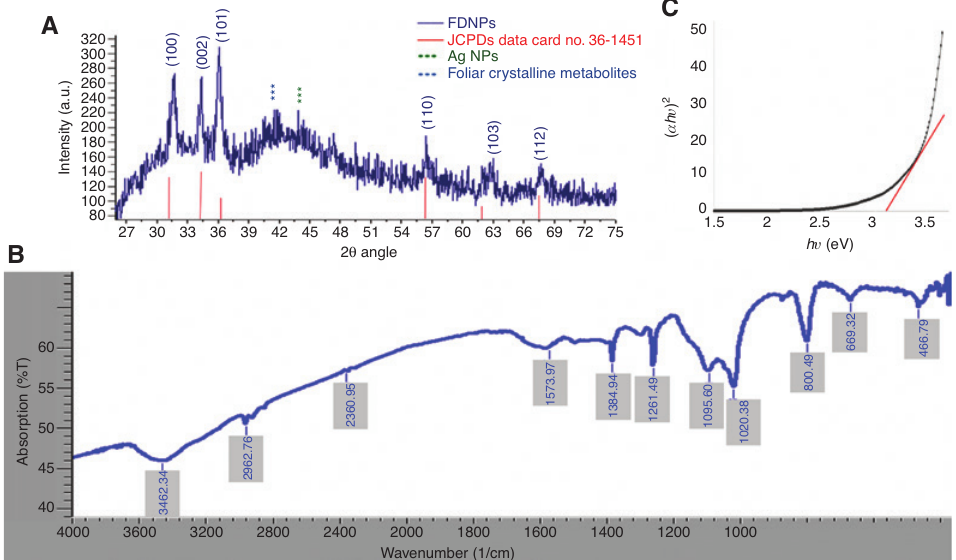
Figure 2: Foliar doped nanoparticles synthesis at highest doped percentage: (A) XRD diffraction spectrum, (B) FTIR spectra, and (C) plot between h ν (eV) and ( α h ν ) 1/2 for direct bandgap calculation.